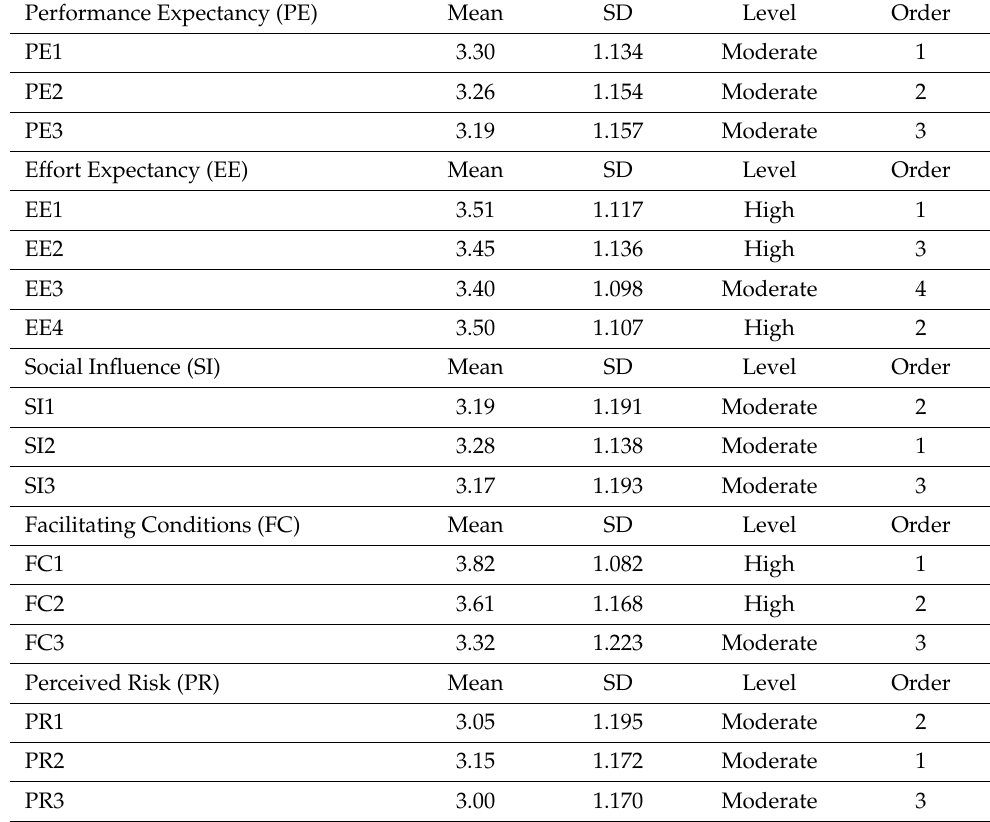
Table 3. Mean and standard deviation of the study’s